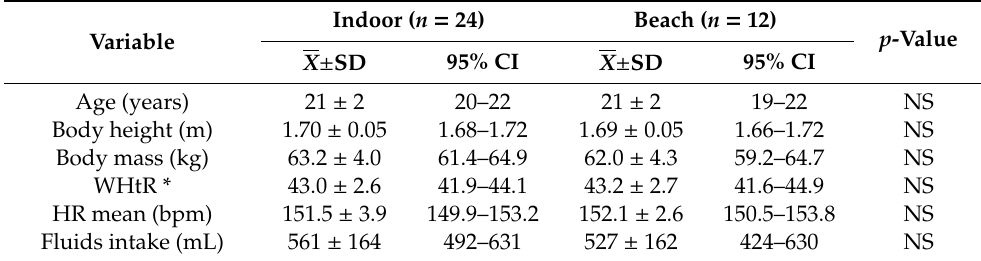
Table 1. Characteristics of female handball players taking part in the simulated indoor and beach